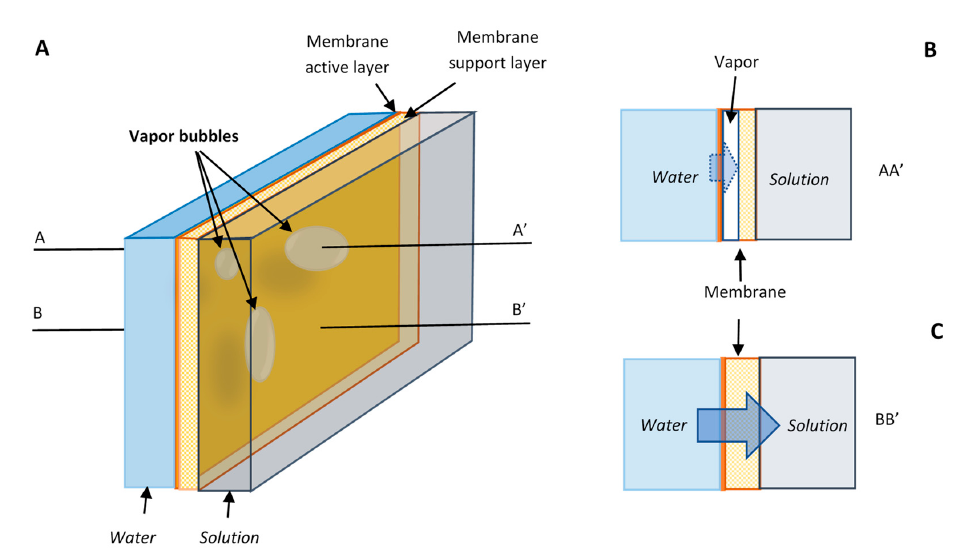
Figure 3. A schematic model for water transport under osmotic pressure. ( A ) Vapor bubbles can form and trapped in the porous support layer of a membrane. ( B ) The membrane area blocked by bubbles is unavailable or inefficient for water transport. ( C ) Water can only transport at full strength through the unblocked membrane surface.